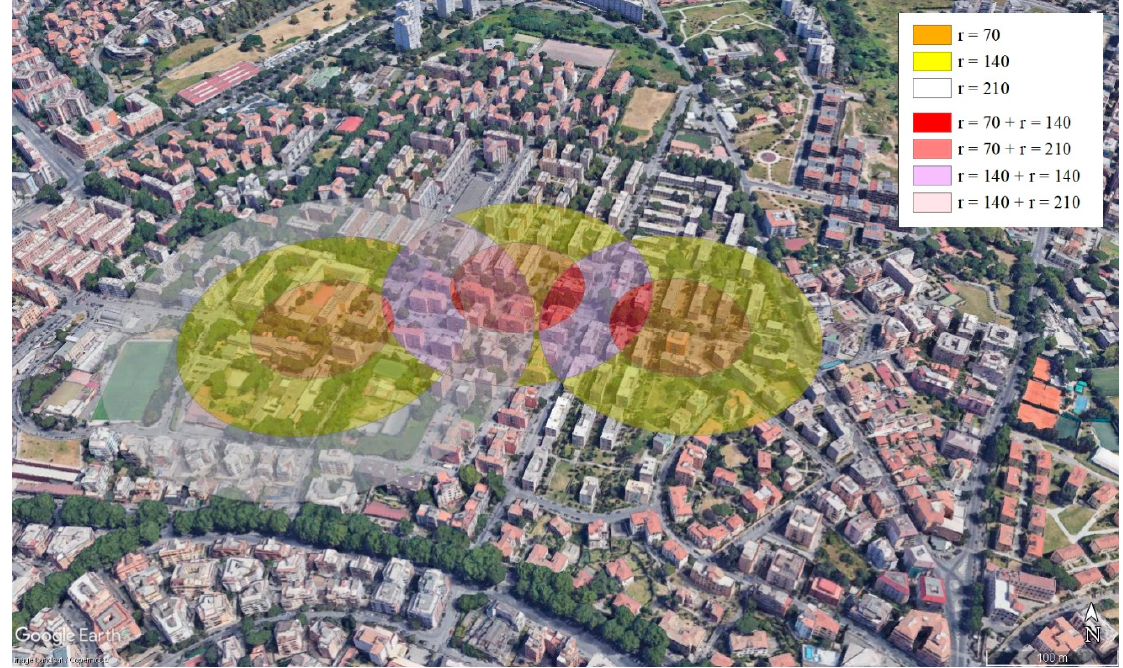
Figure 10. Prime three-dimensional model concerning the circular buffer zones defined by different radio base stations (the same as in Figure 8) in a GIS environment. Source: authors’ elaboration.